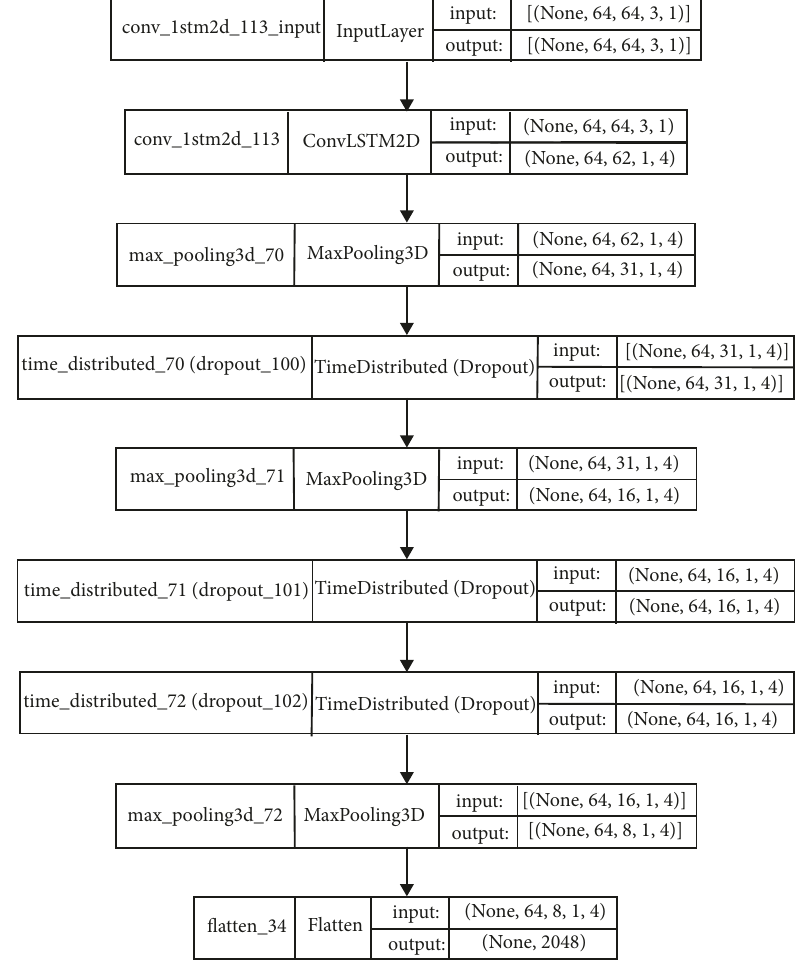
Figure 3: Structure of the proposed LSTM model. Table 1: Training and testing datasets.